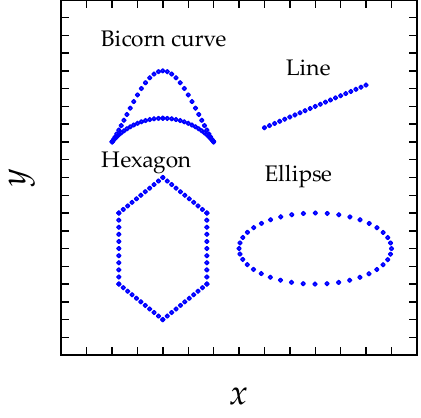
Figure 4. Point-clouds created by using the parametric-equation-based approach.